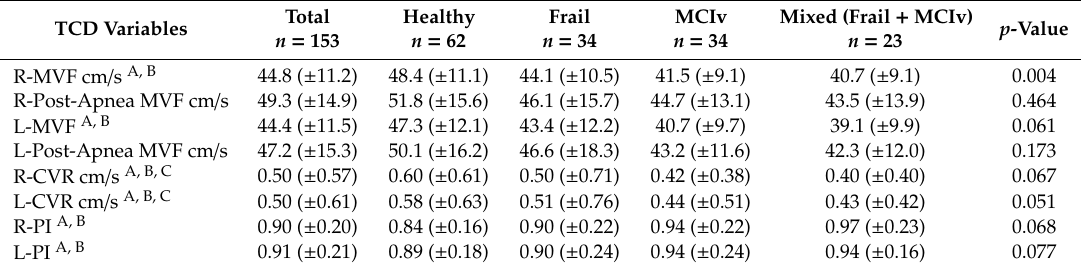
Table 2. Transcranial Doppler ultrasound TCD parameters for the middle cerebral artery vascular reactivity in healthy, frail, MCIv and mixed subgroups.